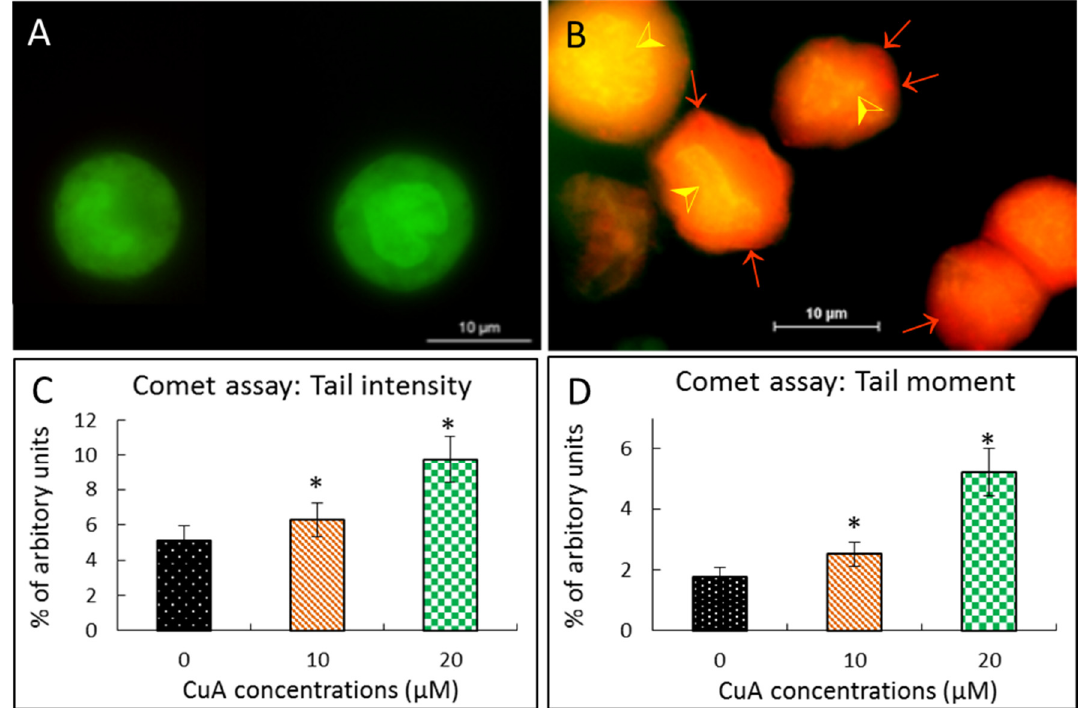
Figure 2. Cuminaldehyde caused nuclear fragmentation in human colorectal COLO 205 cells. ( A and B ) Acridine orange staining; COLO 205 cells were incubated without ( A ) with 20 μ M ( B ) cuminaldehyde, respectively, for 48 h, then stained using acridine orange. The orange vacuoles in COLO cells demonstrate that they existed acidic; ( A ) Typical picture of control cells accompanying intact nucleus with green fluorescence that implicates a good cell viability; ( B ) Typical picture of test cells incubated with cuminaldehyde with lysosomal vacuolation (arrows) and nuclear fragmentation (arrow heads) were found; ( C and D ) Comet test. Cuminaldehyde’s effect on intensities of tail ( C ) as well as moment ( D ). Human colorectal COLO 205 cells were incubated with cuminaldehyde at the indicated concentrations for 48 h. Data are shown as means plus/minus standard error of the mean, n = 125. *, Significant difference ( p < 0.05) from the control. CuA, cuminaldehyde.